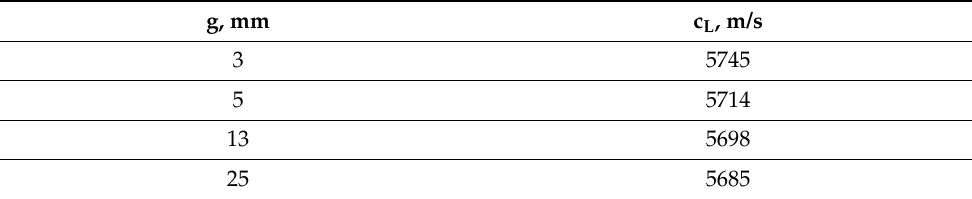
Table 4. Velocity of longitudinal ultrasonic wave vs. wall